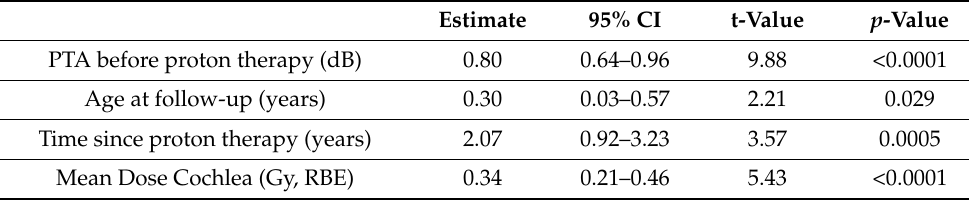
Table 5. Effect size estimates and 95% confidence intervals estimated from a linear mixed-effects model on PTA after proton therapy (longitudinal data) with a random intercept per ear nested within patients. The model included 222 audiometric tests on 101 ears of 51 patients. (One patient had a test on only one